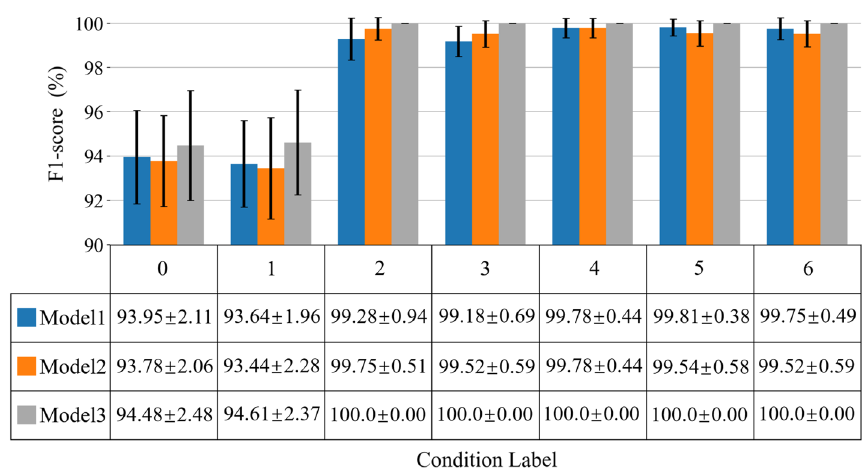
Figure 8. F1-score performance index of different models on noiseless dataset.